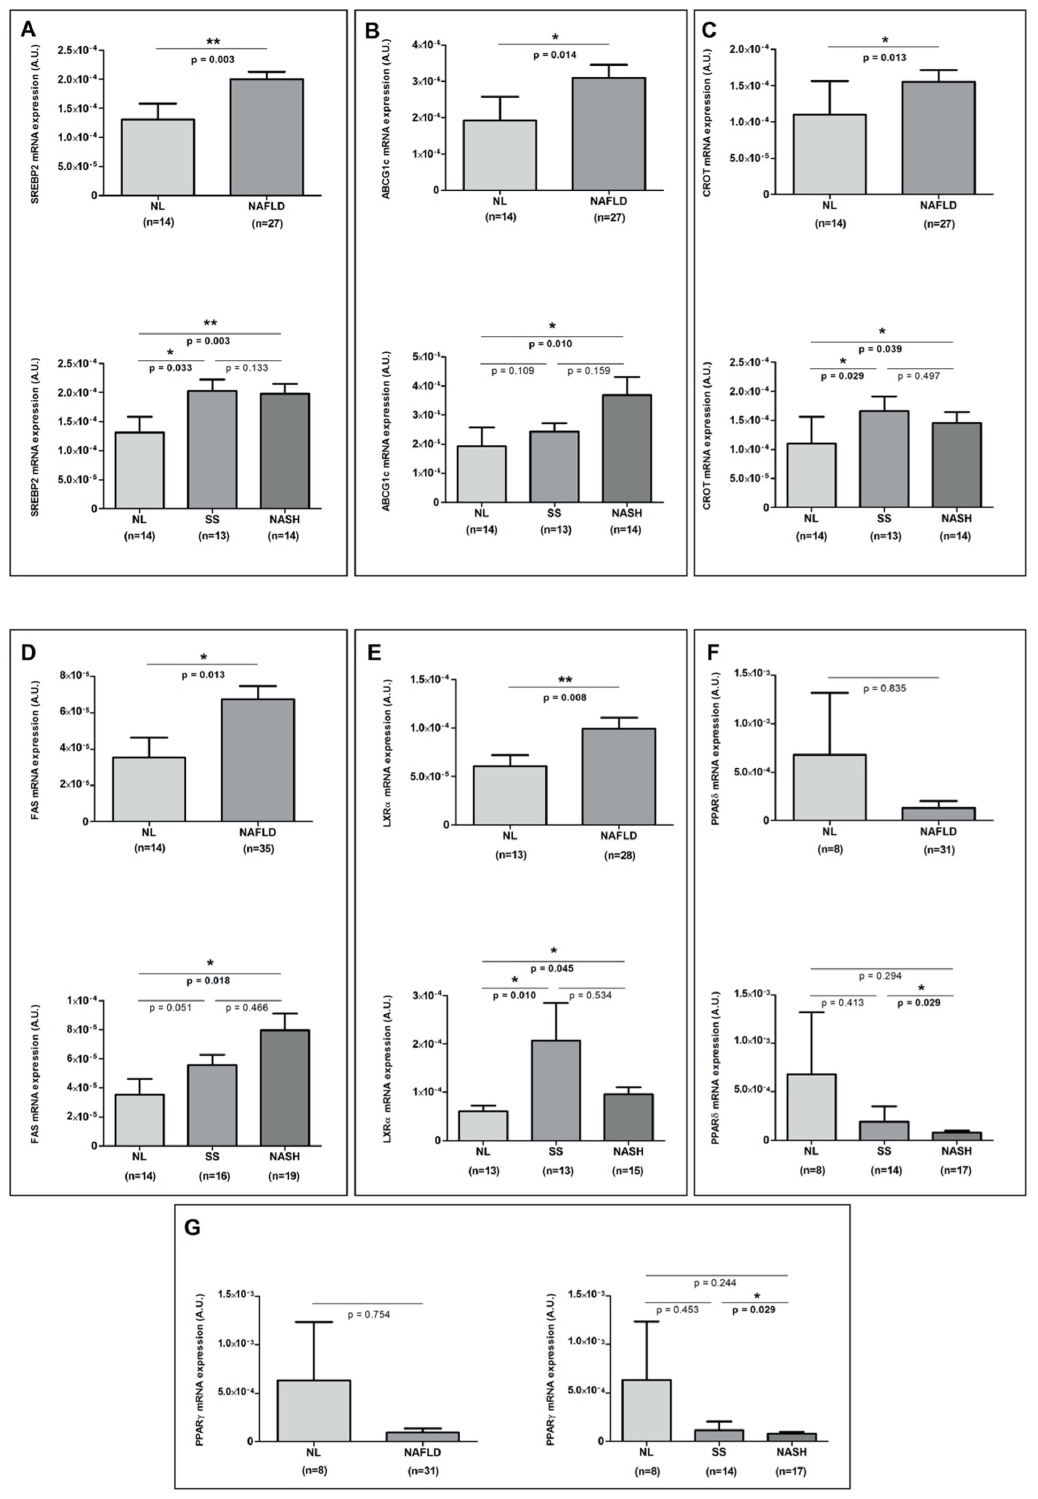
Figure 2. Differential mRNA hepatic expression of ( A ) SREBP2, ( B ) ABCG1c, ( C ) CROT, ( D ) FAS, ( E ) LXR α , ( F ) PPAR δ , and ( G ) PPAR γ between NL vs. NAFLD groups and between NL, SS, and NASH groups. NL; normal liver; NAFLD, nonalcoholic fatty liver disease; SS, simple steatosis; NASH, nonalcoholic steatohepatitis; SREBP2, sterol regulatory element-binding protein 2; ABCG1c, ATP-binding cassette (ABC) transporter 1c; CROT, carnitine O-octanoyltransferase; FAS, fatty acid synthase; LXR α , liver X receptor alpha; PPAR δ , peroxisome proliferator-activated receptor delta and PPAR γ , peroxisome proliferator-activated receptor gamma. * p < 0.05 and ** p < 0.01 are considered statistically